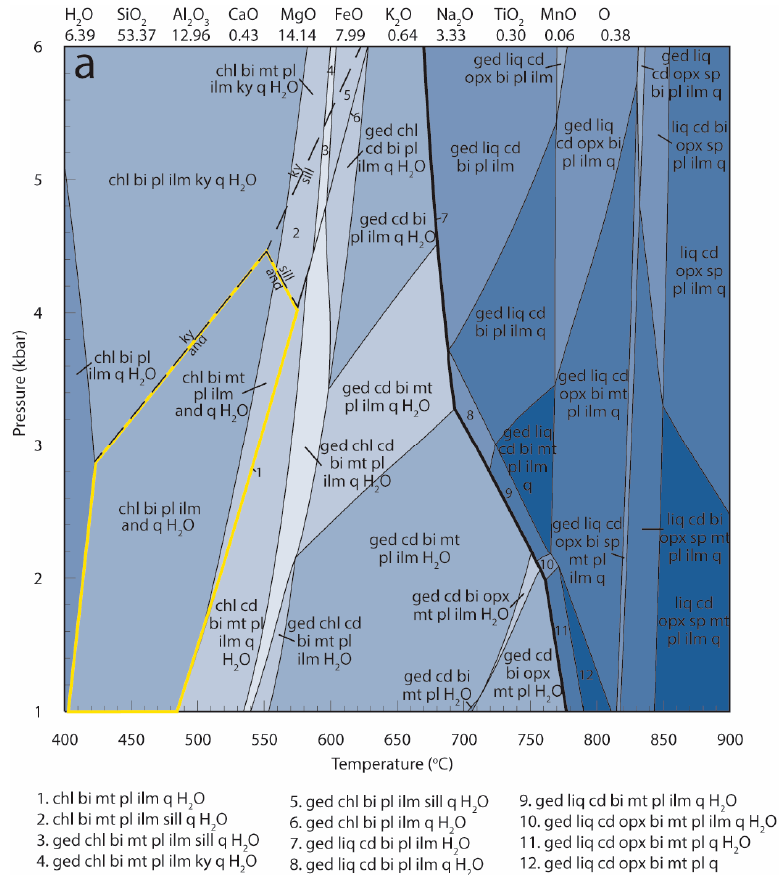
Figure 8. P–T pseudosection calculated using the same melt reintegrated composition as in Figure 6, but using ds55 rather than ds62 to explore the stability of orthoamphibole. The fields highlighted in yellow contain andalusite. The bold black line represents the solidus. H 2 O is set to excess below the solidus. Differences in the subsolidus and suprasolidus magnetite models in ds55 resulted in differences in fields across the solidus.